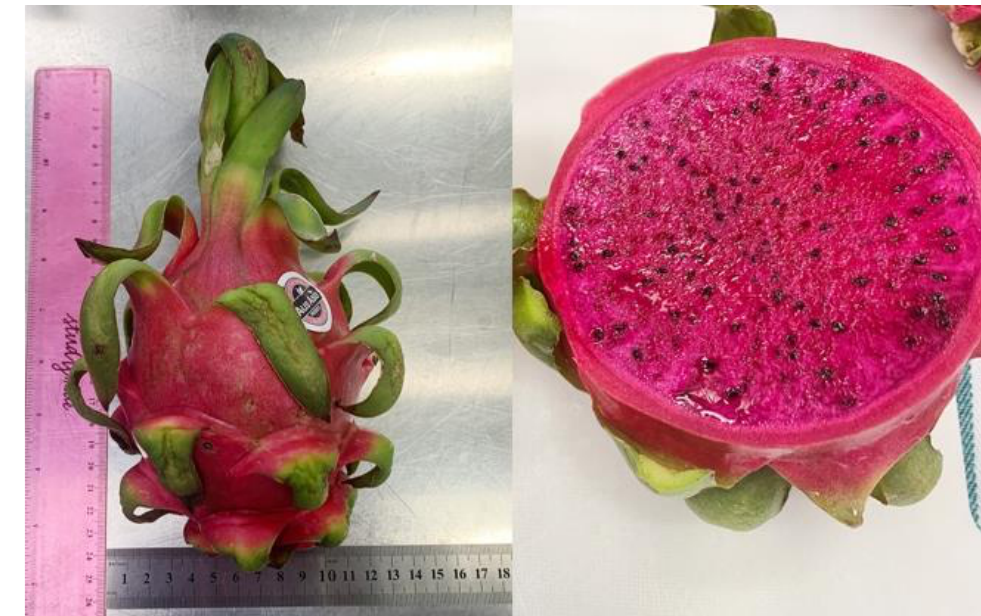
Figure 1. Red pitaya